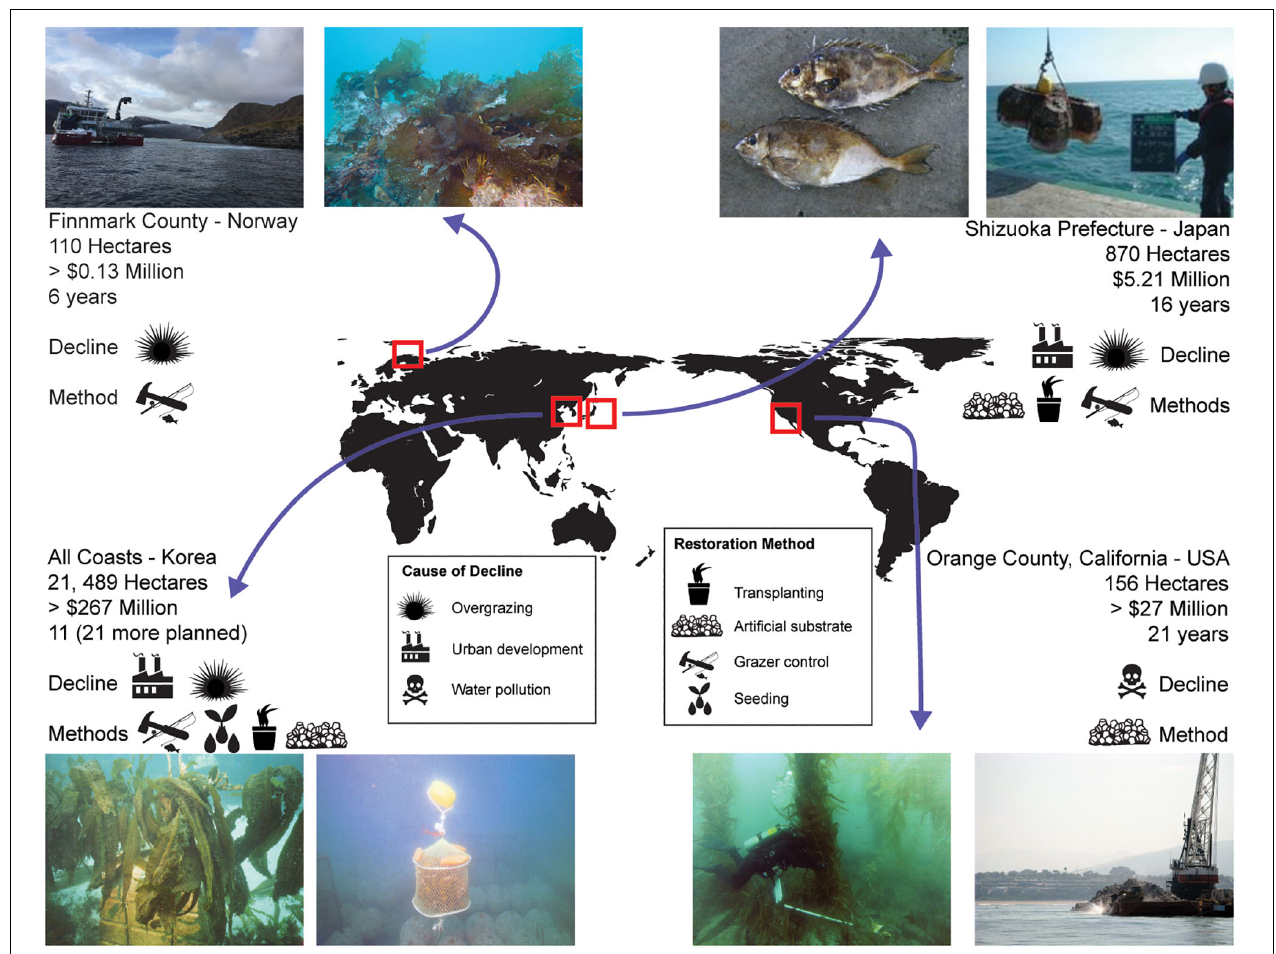
FIGURE 2 | Location, methods, cause of decline, size, and costs of the four large scale kelp restoration case studies. All costs are reported in USD for the year 2010.